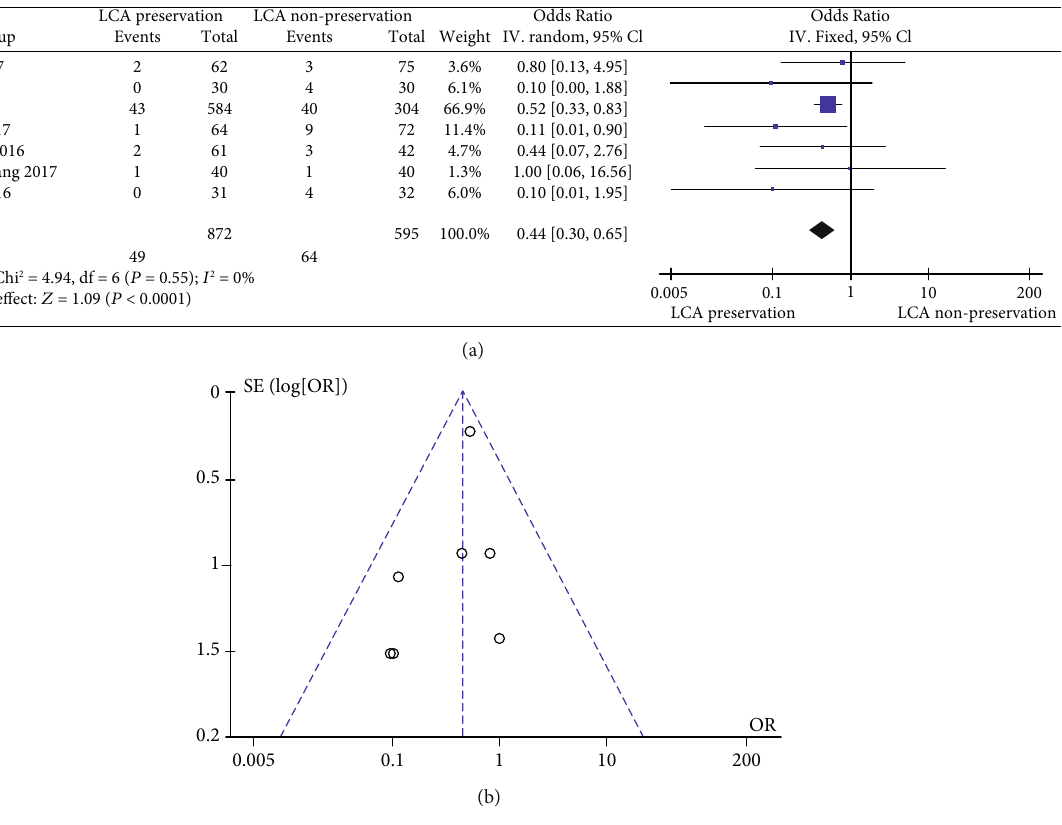
Figure 6: (a) Forest plot of anastomotic leakage; (b) funnel plot of anastomotic leakage. 0.0008)Total Heterogeneity: Chi 2 = 0.41, df = 1 ( P = 0.52); I 2 = 0% Test for overall effect: Z = 3.35 ( P =